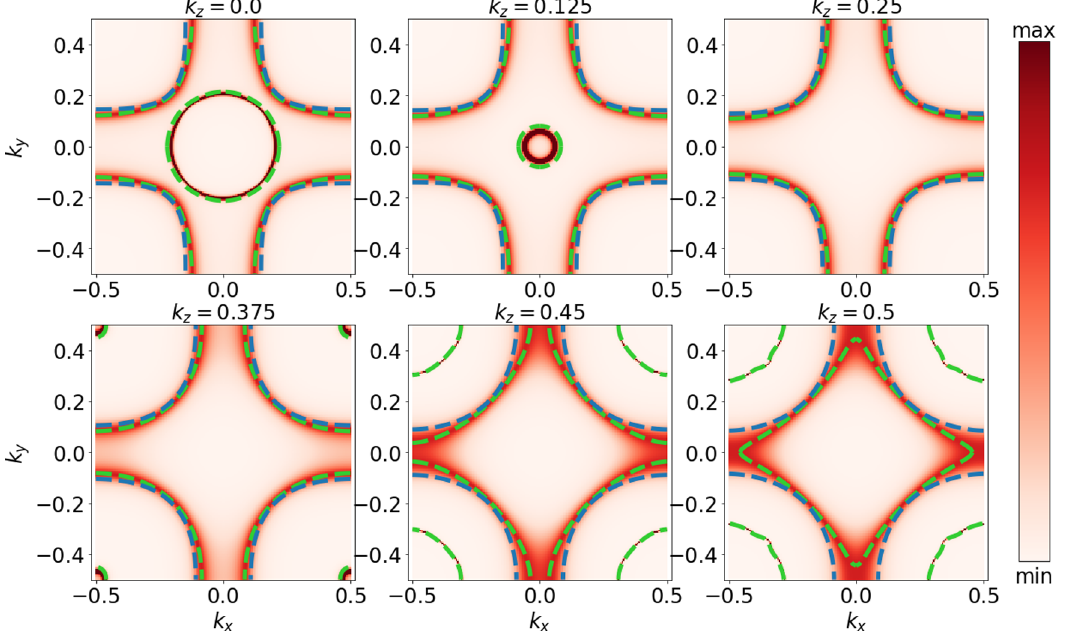
FIG. 3. Many-body Fermi surfaces for NdNiO 2 shown along with the DFT Fermi surface for NdNiO 2 (dashed green line) and CaCuO 2 (dashed blue line). The many-body Fermi surface is defined via a false-color plot of Tr ½ A ð ω ¼ 0 Þ(cid:2) , obtained as described in the text from a narrow energy window calculation with U ¼ 3 . 1 eV at T ¼ 290 K. Note that for CaCuO 2 the DFT and DMFT Fermi surfaces are